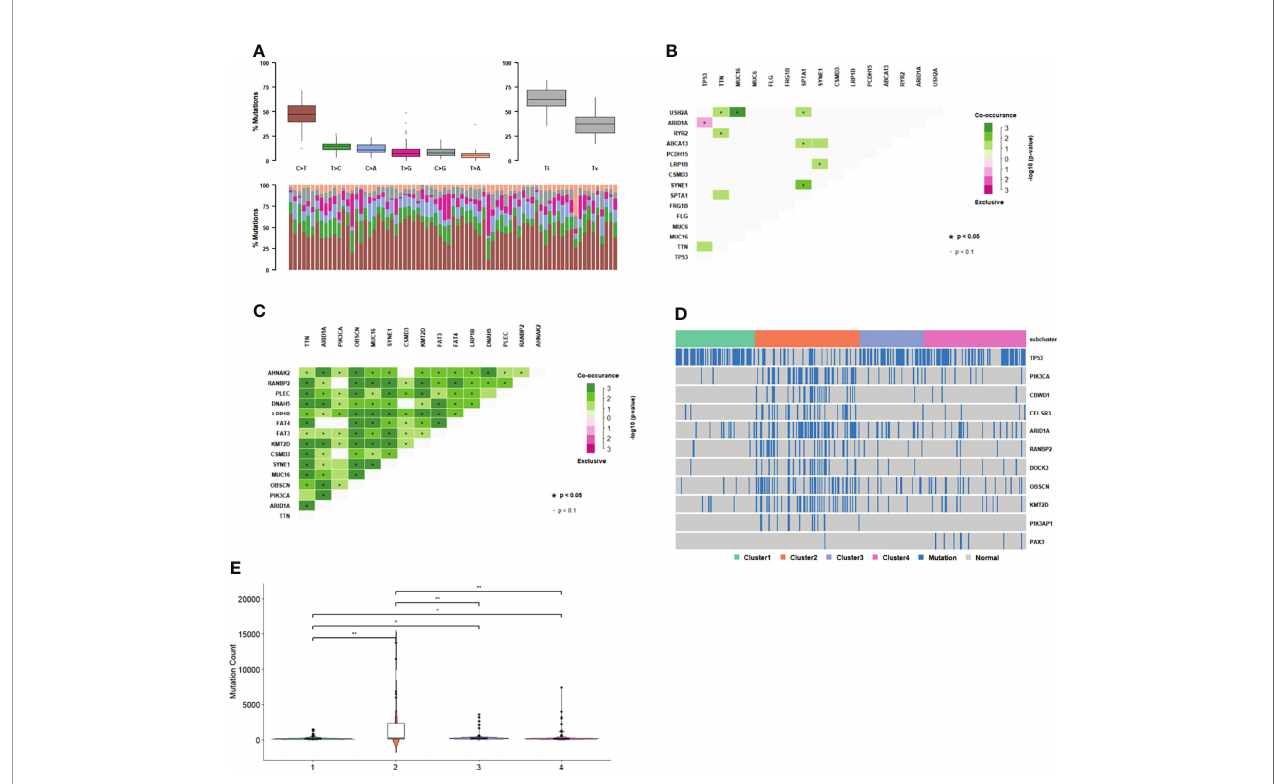
FIGURE 4 | Gene mutation in subgroups. (A) Mutation type distribution in cluster 1. (B) Co-occurrence and mutual exclusivity of genetic alterations in cluster 1. (C) Co-occurrence and mutual exclusivity of genetic alterations in cluster 2. (D) Gene mutation distribution in subgroups. (E) Distribution of mutation number among